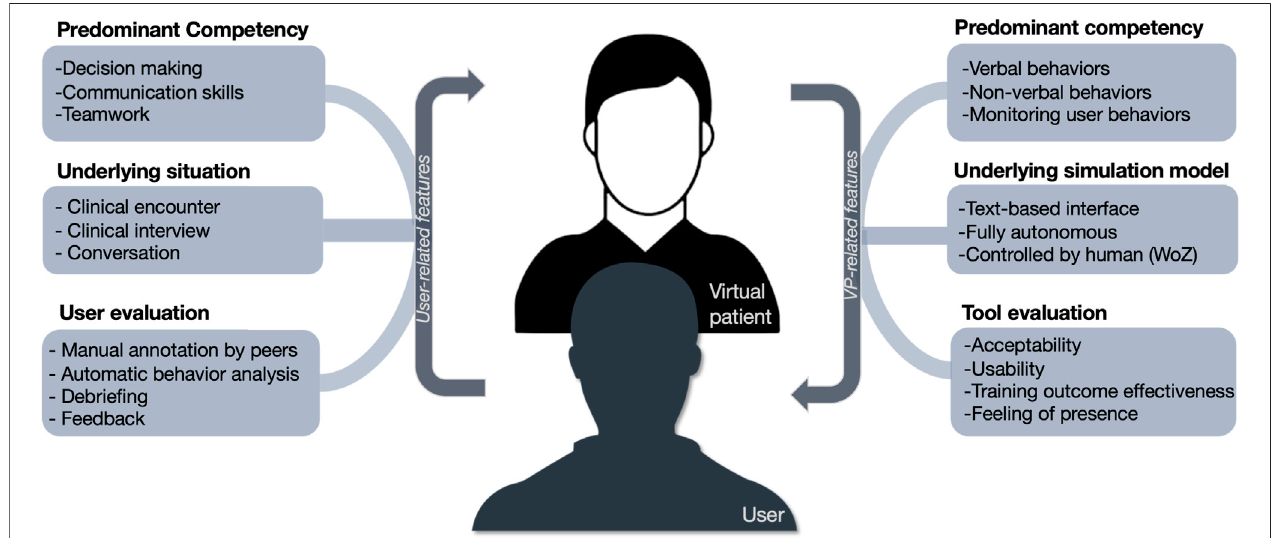
FIGURE 2 | Key features of healthcare simulation tools using embodied virtual patients (VPs), applicable to the user and the VP. On the left, those concerning the user (e.g., clinician, student), including the predominant competencies targeted for training, the type of underlying situation simulated, as well as the user evaluation ; On the right, those concerning the embodied virtual patient, including the predominant competencies of the VP, the underlying simulation model , and the tool evaluation by the user. WoZ: Wizard-of-Oz